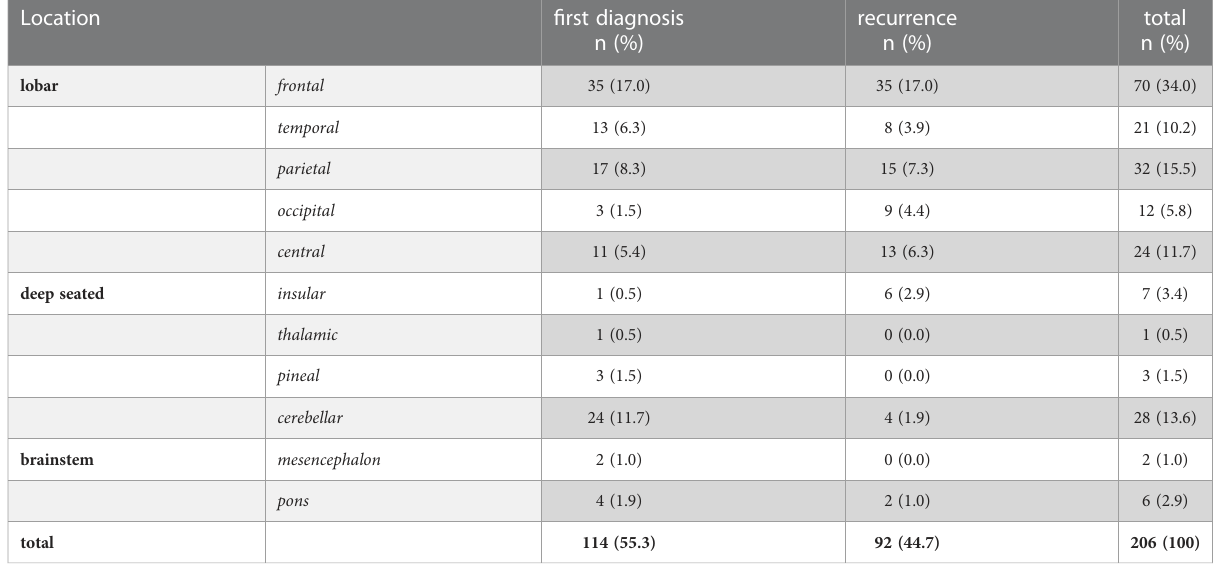
TABLE 1 Biopsy locations in primary and recurrent disease.